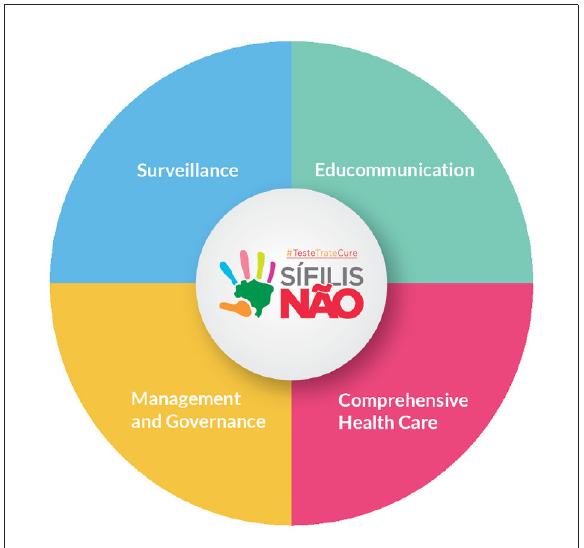
FIGURE1 “Syphilis No!” Project development